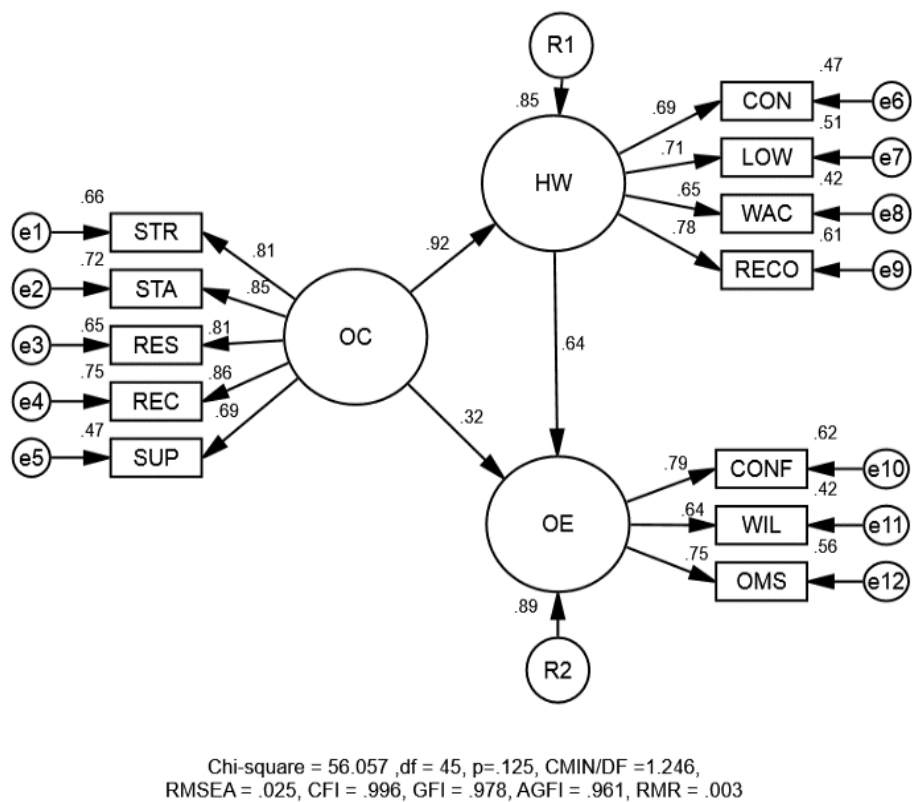
Figure 4. Model based on research hypothesis after the Modification Model